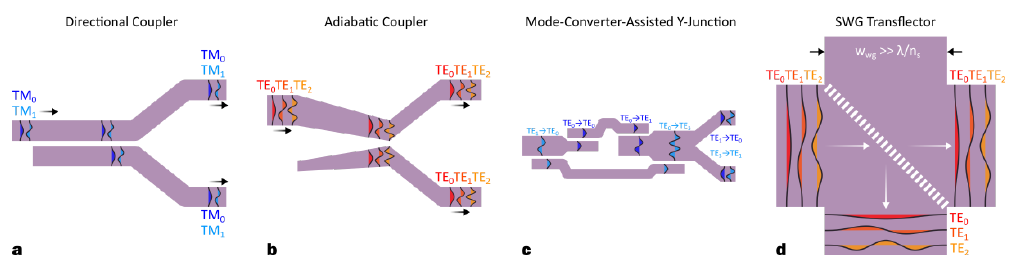
Figure 17. The schematics for different silicon multi-mode splitters based on ( a ) directional coupler [211],